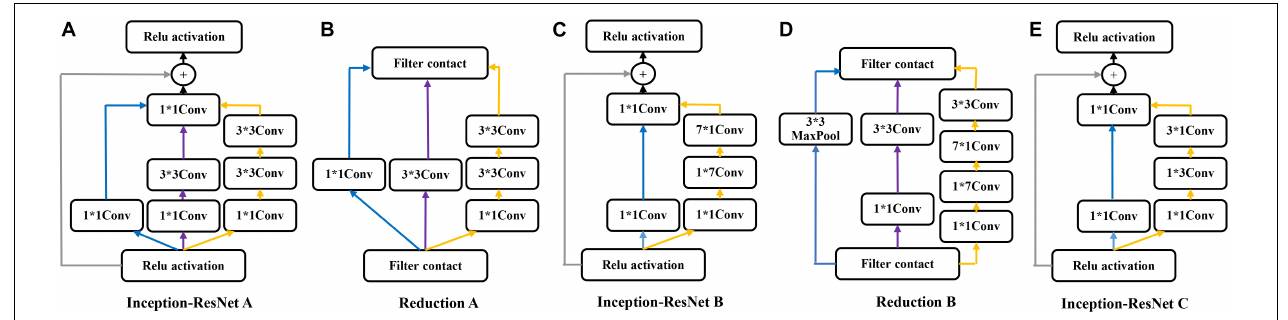
FIGURE 2 | The architecture of the Inception-ResNet A,B,C and Reduction